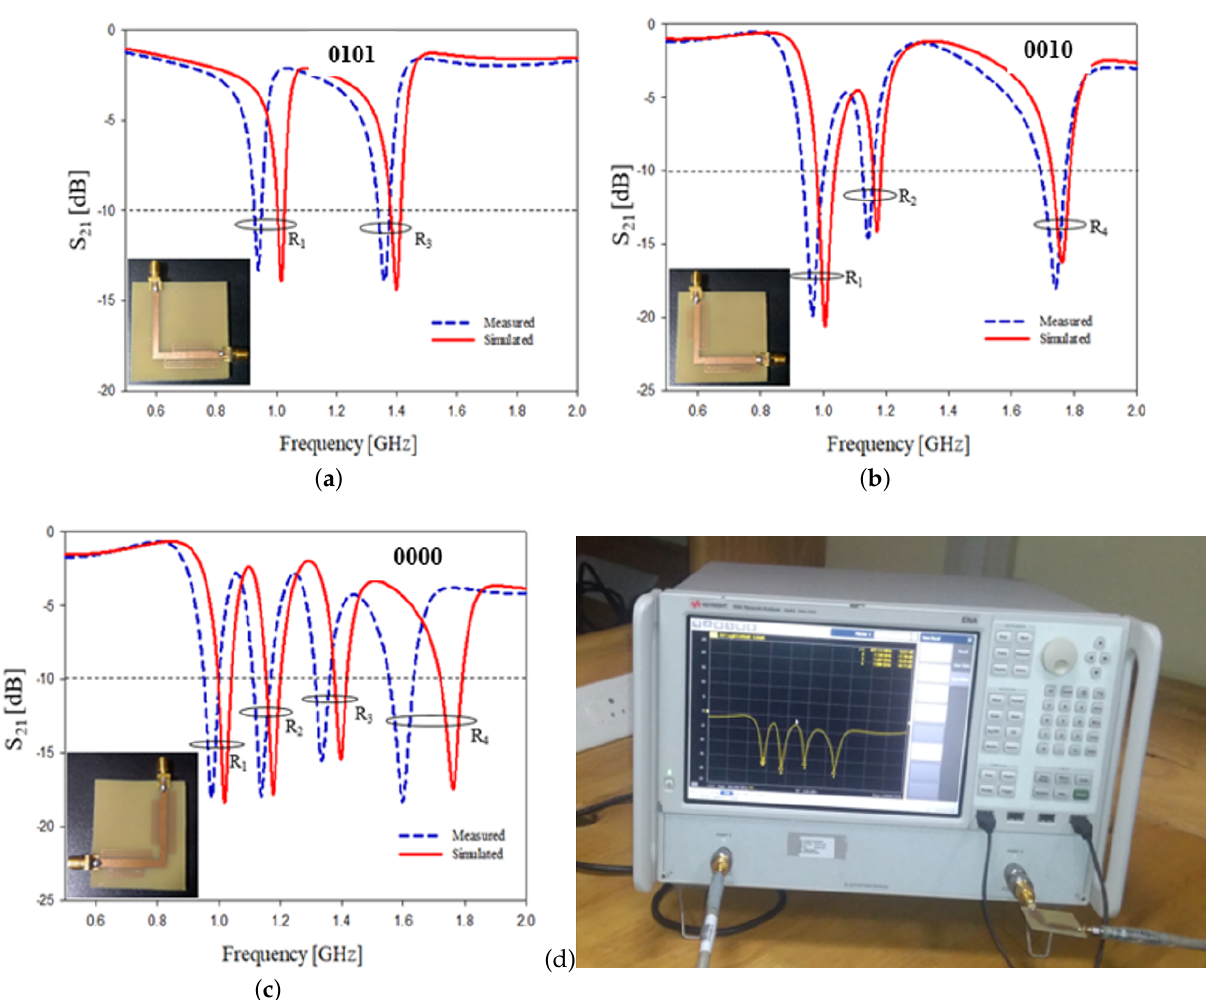
Figure 14. ( a ) Frequency Response for tag with code 0101 ( b ) Frequency Response for tag with code 0010 ( c ) Frequency Response for tag with code 0000 ( d ) Measurement setup of 4-bit tag